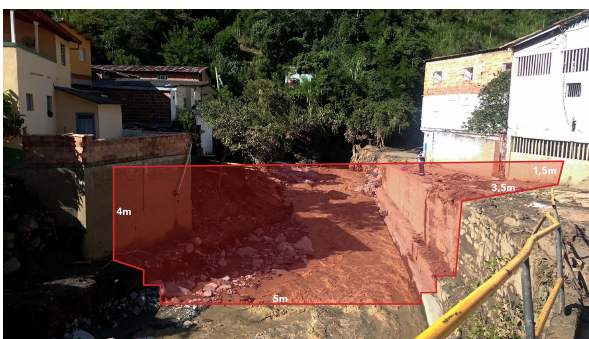
Figure 4. Channel cross section showing an example of flooded in- frastructure during the flash flood event. The section shows mud marks on the walls of adjacent houses, with heights varying be- tween 0.5 and 1.2m. The houses in the picture are located 4–5m away from the channel. The photograph also shows the width of the channel and the total estimated depth during the flash flood. The cross section is downstream from the bridge shown in the